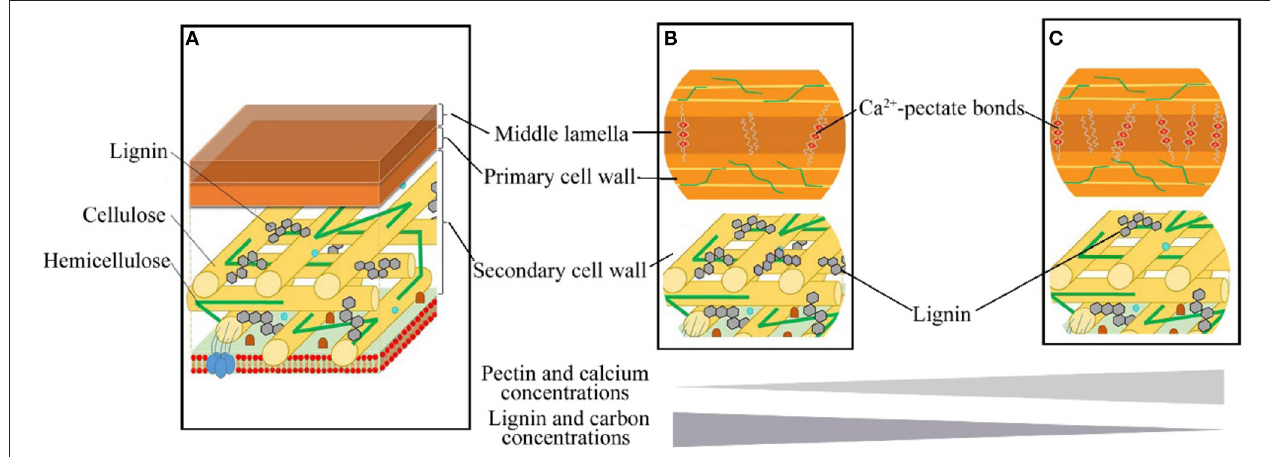
FIGURE 6 | The leaf cell wall composition and structural tradeoffs of woody dicots. (A) The middle lamella, mainly made up of Ca 2 + -pectate, is the outermost layer of the cell wall; the primary cell wall, mainly consist of cellulose and hemicellulose, is located outside of the plasma membrane; the secondary cell wall is located between the primary cell wall and the plasma membrane, mainly consist of lignin, cellulose microfibrils [referencing to Loix et al. (2017)]. (B,C) indicated the tradeoff between Ca and C in structural strategies. (B) Cell wall build by less Ca 2 + -pectate in middle lamella but more lignin (C) in the secondary cell wall. (and C) Cell wall build by more Ca 2 + -pectate in middle lamella but less lignin (and C) in the secondary cell